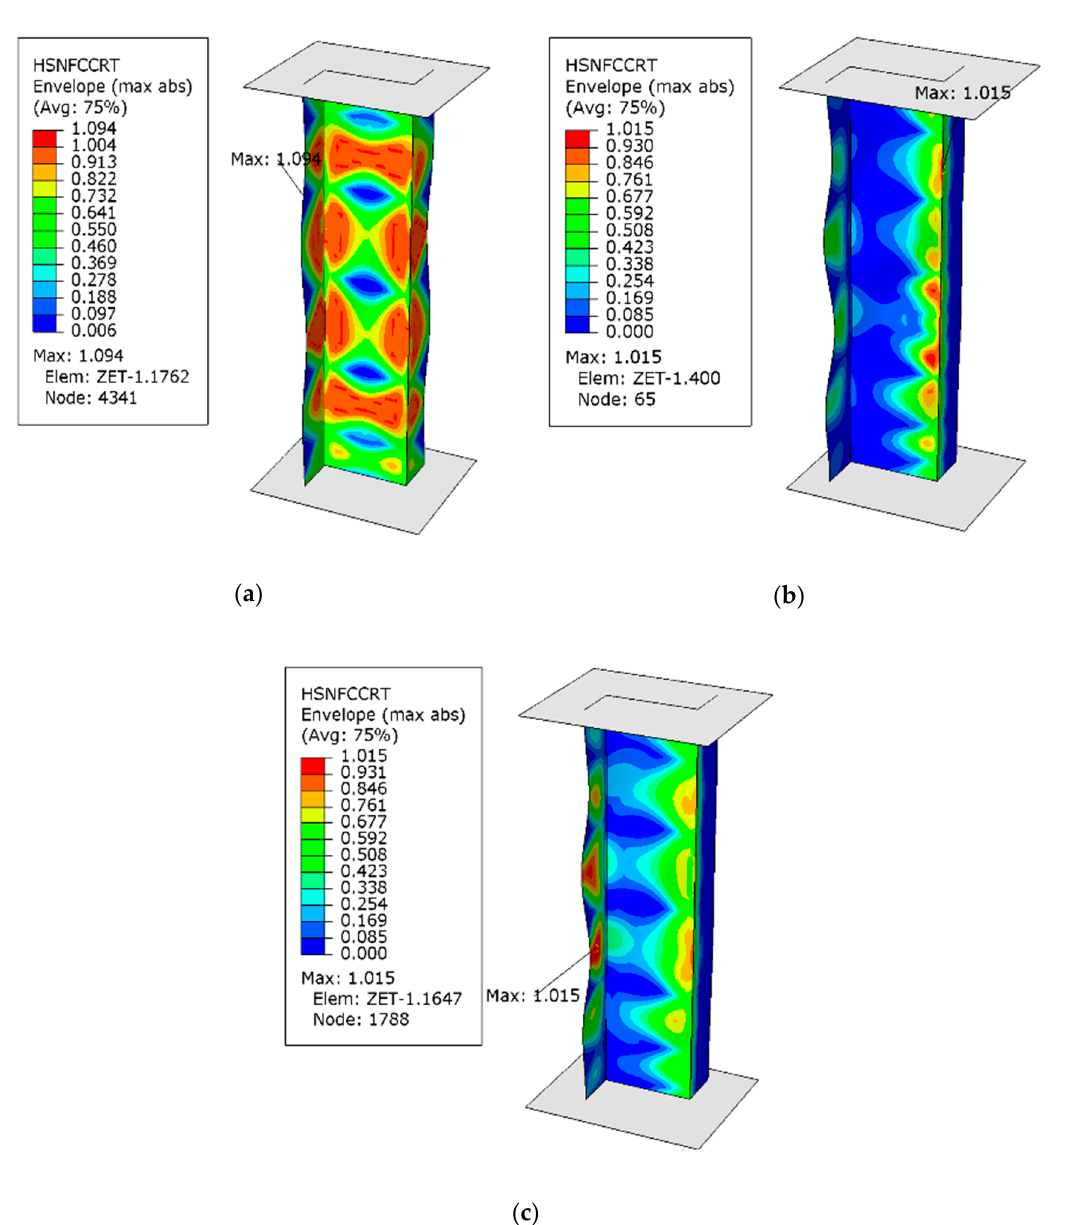
Figure 6. HSNFCCRT of the analyzed composite structures: ( a ) axial compression; ( b ) e 1 = 10 mm; ( c ) e 2 = 6